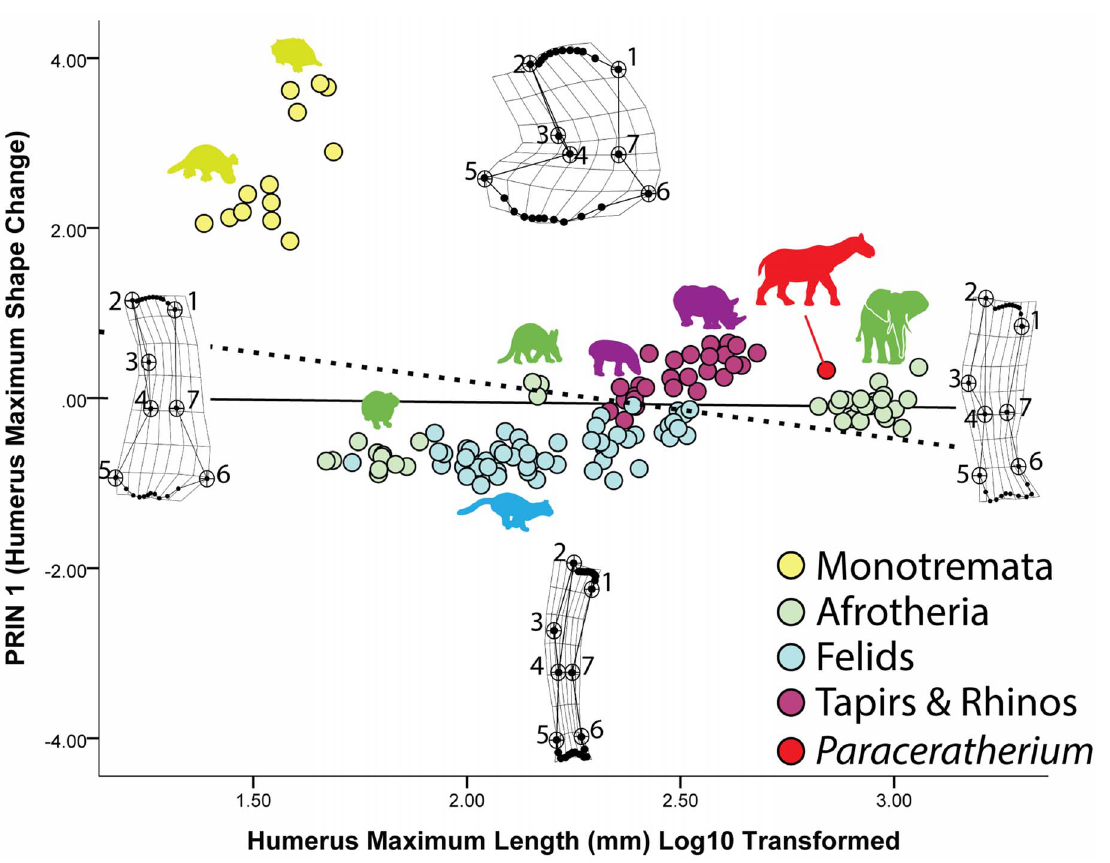
Figure 3. Changes in humerus shape in mammals. Maximum humerus shape change in the sample is shown on the Y-axis (PRIN 1), whereas humerus shape changes associated with size are shown on the X-axis. Note that on the PRIN 1 axis, monotreme taxa plot separately from other mammals in the sample, and show a much more expanded and robust humerus. On the X-axis, the sub-articular bone region narrows significantly with increasing size, and the shapes of these regions become more convex and/or distinct.